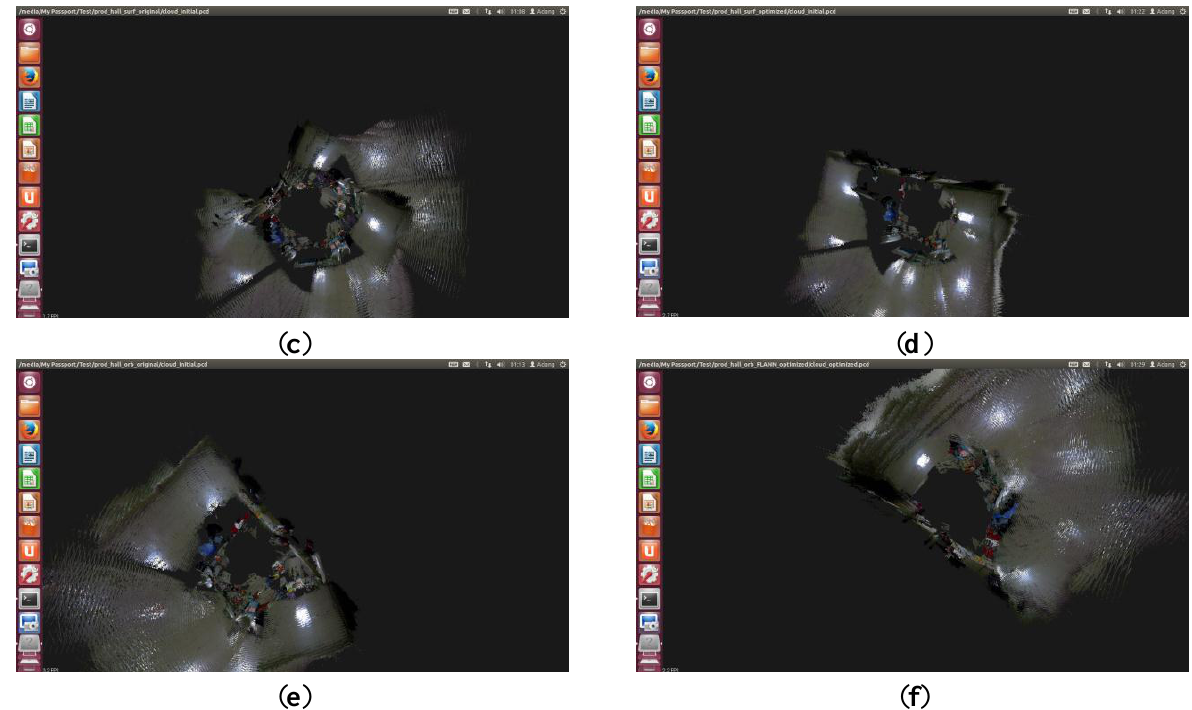
Figure 15. The splicing results for the improved RGB-D SLAM based on Dr Robot X80.